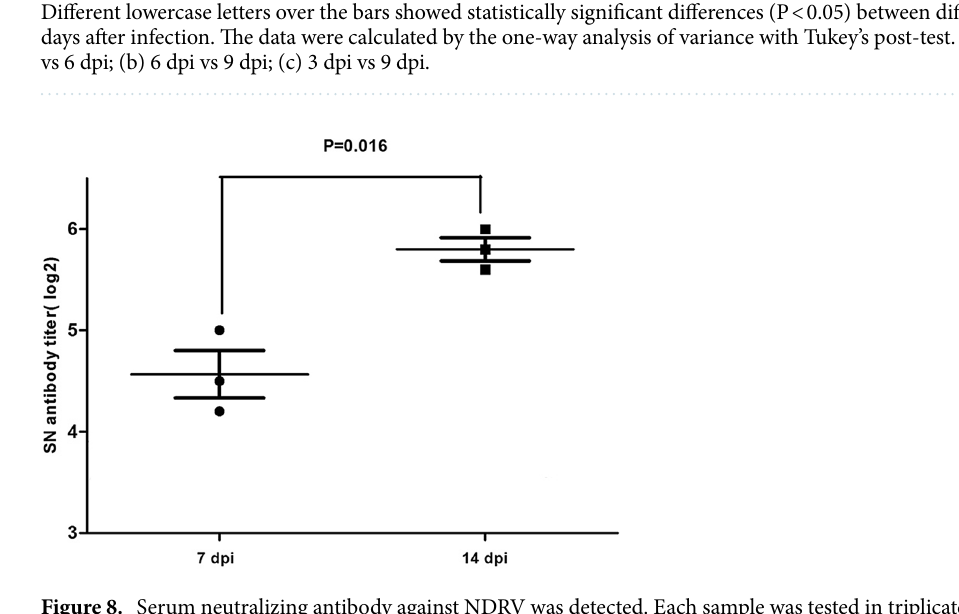
Figure 8. Serum neutralizing antibody against NDRV was detected. Each sample was tested in triplicate. Serum neutralizing antibody titers were expressed as the reciprocal of the log2 of the highest dilution serum dilution that inhibited 50% CEF death. The negative antibody titer was zero. Data are expressed as mean ± SD (n = 3). Significant differences were determined by the two-tailed Student’ s unpaired t